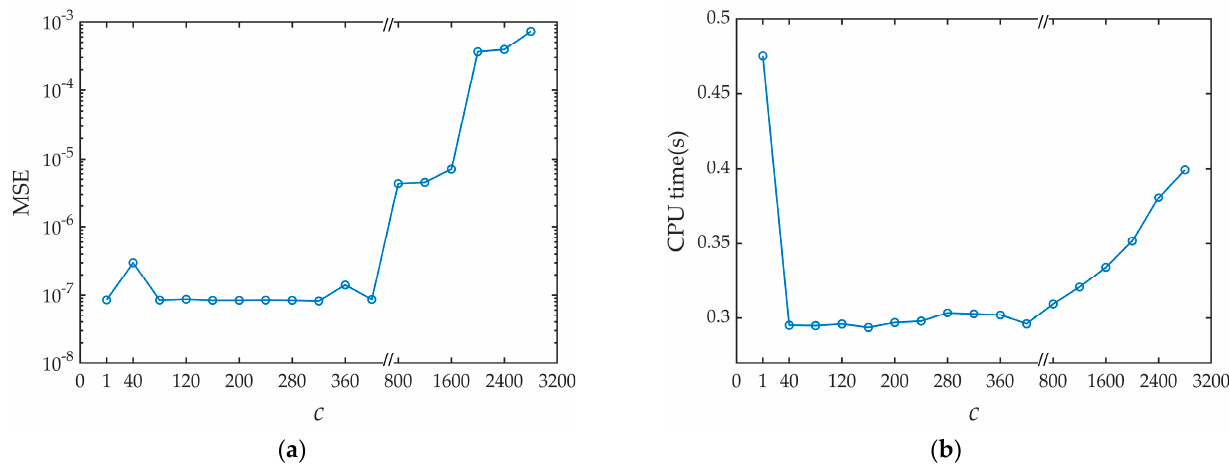
Figure 10. The effect of c on the estimation of hopping time: ( a ) The effect of c on the MSE. ( b ) The effect of c on the CPU time consumed by the hopping-time estimation process.